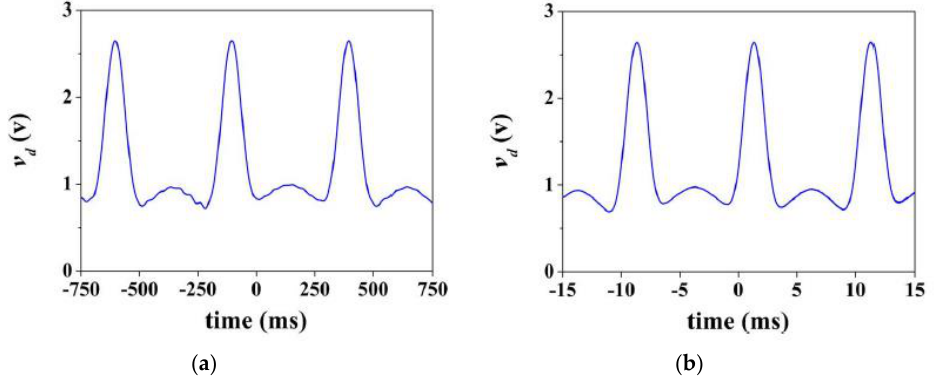
Figure 16. Measured envelope functions. ( a ) 1 rpm; ( b ) 50 rpm. From [22], reprinted with permission.